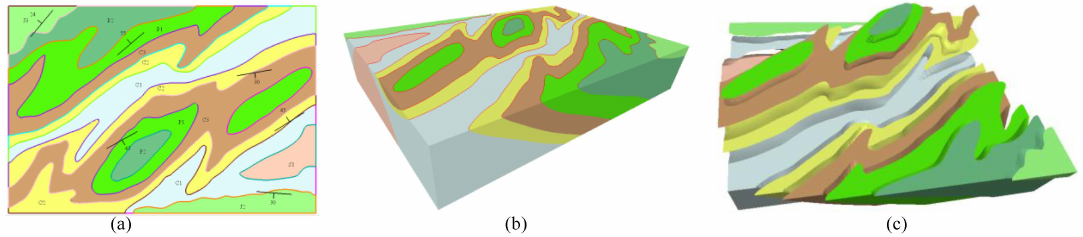
Figure 9. Fold models from a geological map: ( a ) the 2D geological map with attitudes that describe the geological conditions; ( b ) 3D geological model; and ( c ) exploded view of the